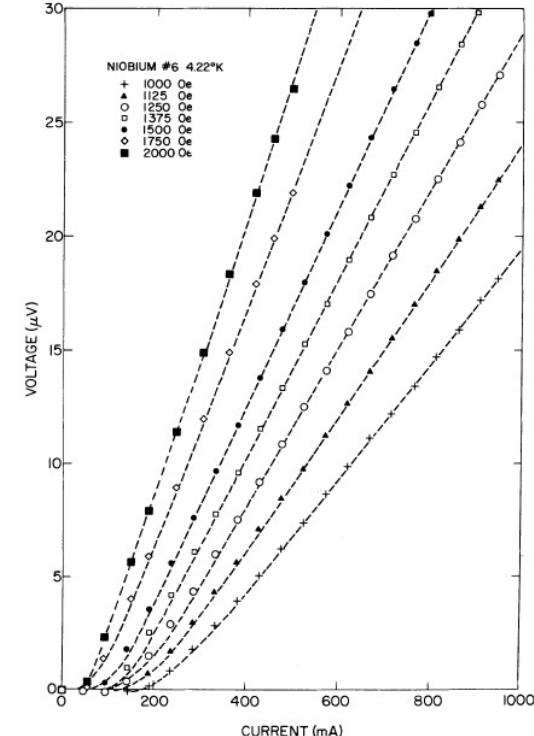
Figure 4. Flux-flow voltage plotted versus the electric current in a niobium foil of 18 µ m thickness and 4 mm width for different perpendicularly oriented magnetic fields. T = 4.22 K; T c = 9.2 K